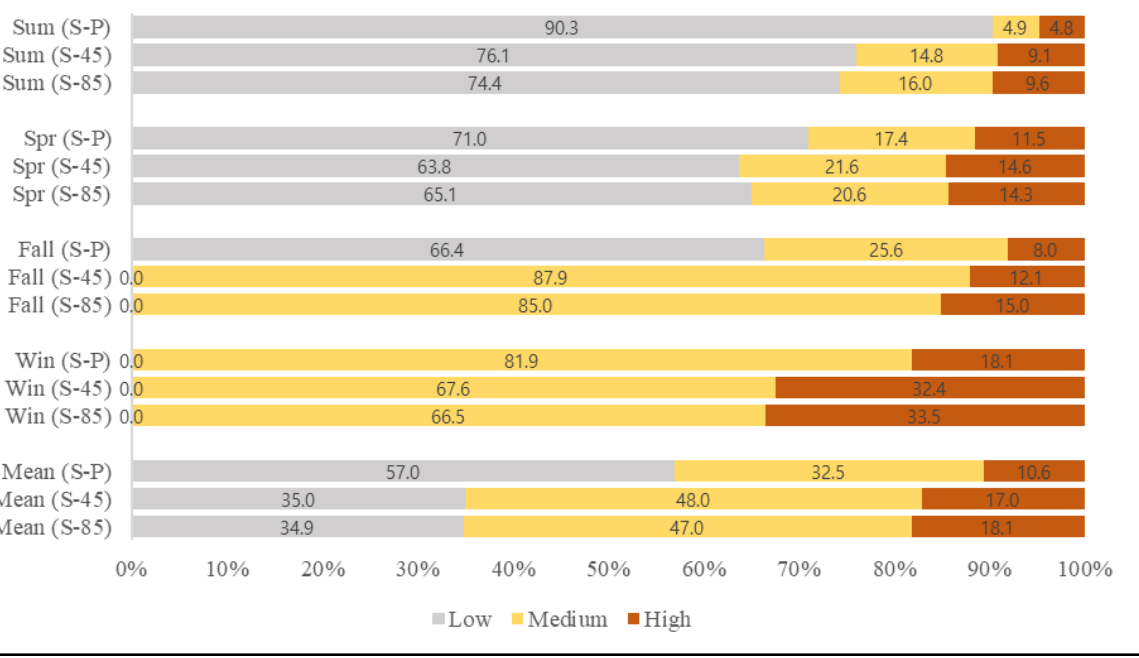
Figure 7. Mean and Seasonal NO 2 concentration comparison for present and future scenarios at Seoul capital city (P = present; 45 = future scenario 4.5; 85 = future scenario 8.5).